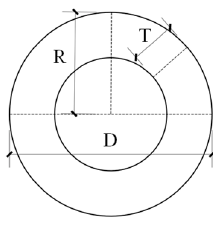
Figure 1. Cross-section of pile body.